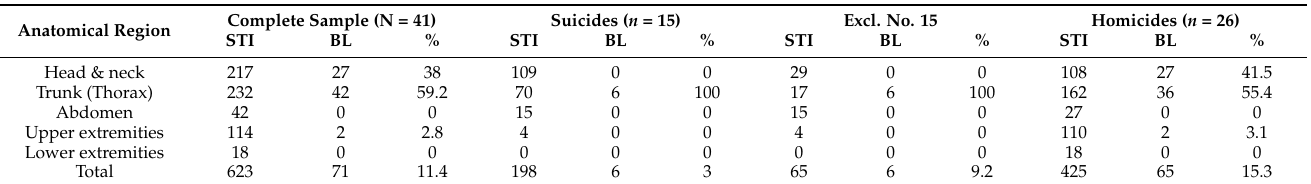
Table 6. Distribution of soft tissue injuries (STI) vs. bone lesions (BL) in the complete sample, the suicide (incl./excl. case no. 15) and the homicide